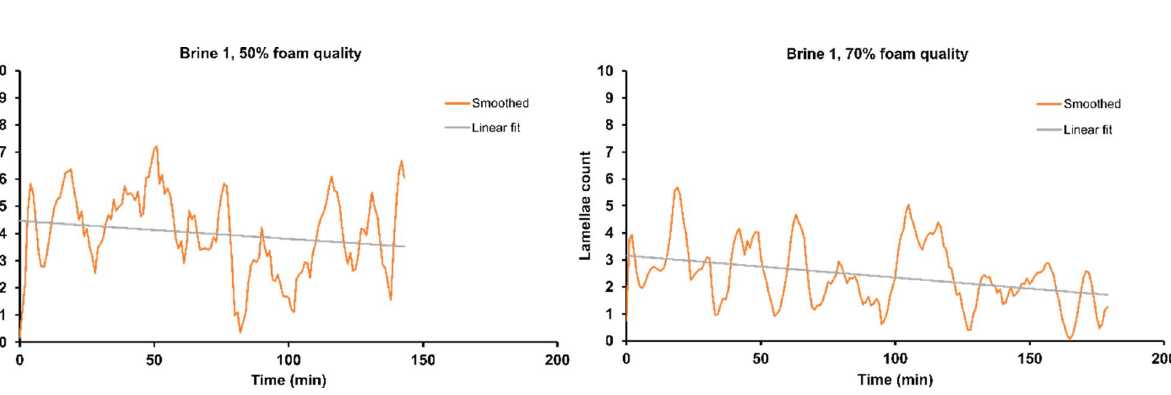
Figure 9. Decay of Savitzky–Golay filtered lamellae counts in the porous media of microfluidic chips during control experiments of sealed-off two-phase flow of Sc-CO 2 and Brine 1 in the absence of surfactants, at qualities 50% and 70%. Linear fits used to estimate half-life in the absence of exponential decay.